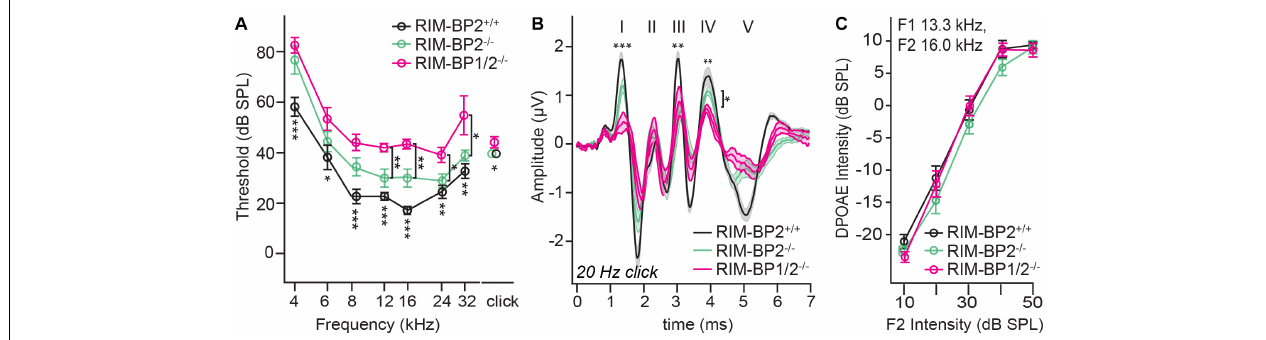
FIGURE 3 | Both RIM-BP1 and -2 are required for normal hearing. (A) Compared to control mice ( RIM-BP2 + / + , black), auditory brainstem response (ABR) thresholds of RIM-BP1/2-deficient mice (magenta) were elevated for all recorded frequencies (indicated by asterisk on top of traces: 4 kHz: p = 0.0007, 6 kHz: